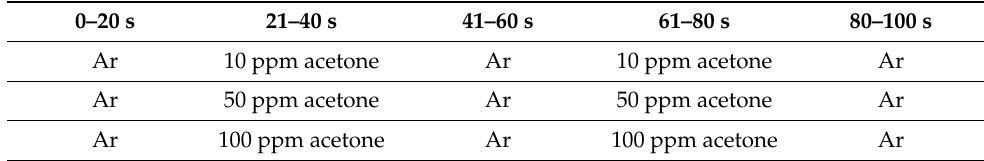
Table 2. Gas concentration in acetone cycle test.